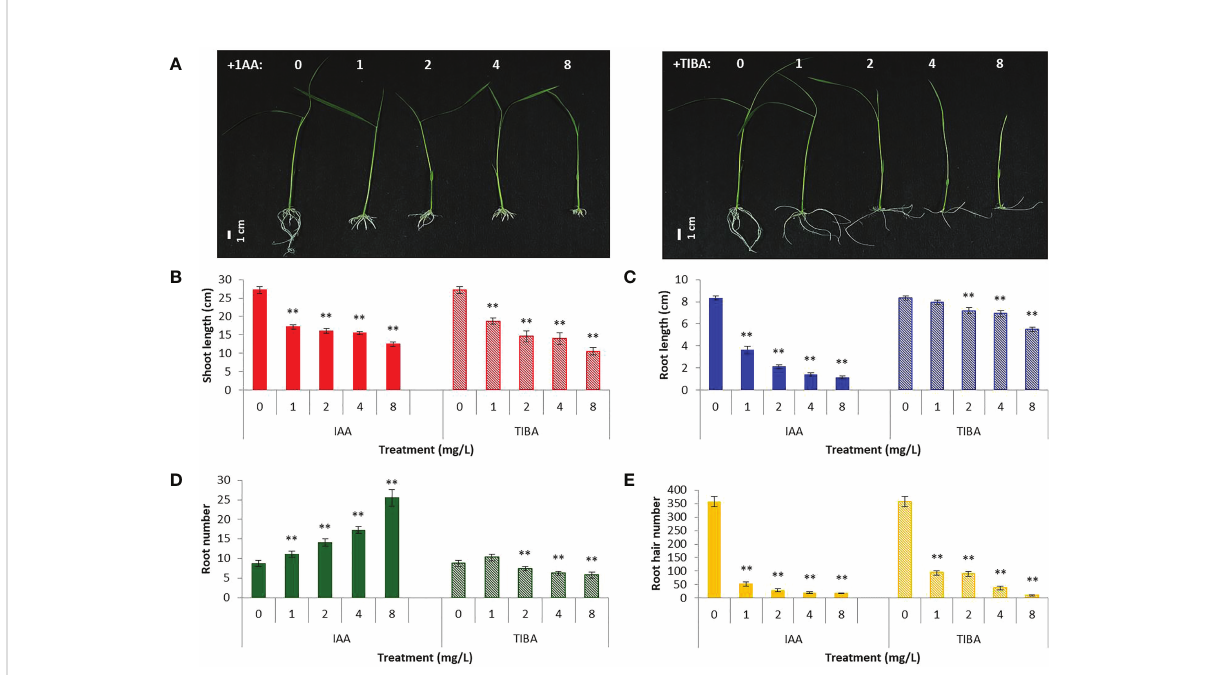
FIGURE 7 Rice seedling morphology and growth parameters when subjected to increasing levels of IAA and TIBA treatments (n = 10). (A) Seedling morphologies when rice seeds were grown over half MS medium containing IAA or TIBA (at 1, 2, 4, and 8 mg/L concentrations) for 15 days. The contrasting root morphologies upon IAA and TIBA treatments are vividly evident. (B) Quanti fi cation of shoot lengths upon IAA or TIBA treatments. Both treatments reduced the shoot lengths. (C) Measurement of the root lengths upon IAA or TIBA treatments. Both treatments reduced the root lengths. (D) Quanti fi cation of root numbers upon IAA or TIBA treatments. While IAA treatments increase the root numbers, TIBA treatments decrease their numbers. (E) Root hair numbers in IAA- and TIBA-treated rice seedlings. Both treatments led to a drastic reduction in root hair numbers. Asterisks (**) indicate differences statistically signi fi cant at 0.01